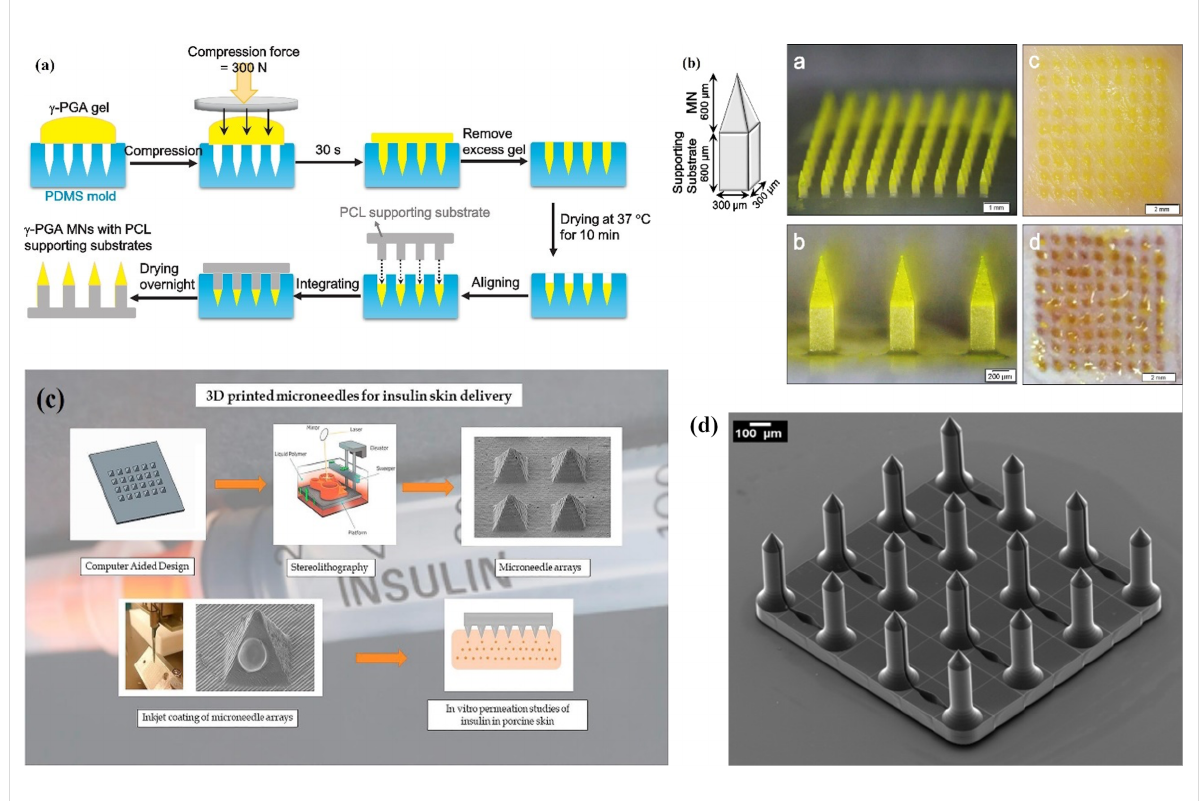
Figure 4: (a) A schematic representation of the manufacturing procedure for producing γ -PGA microneedles, (b) microneedles fabricated via the pro- cedure represented in (a) as used to penetrate pig and mouse cadaver skin [72]. (c) Stereolithography (STL) used to manufacture microneedle arrays followed by coatings of insulin and sugar solution using an inkjet printer [83]. Figure 4c reprinted with permission from ref. [83]. (d) An array of 16 microneedles (2.17 mm × 2.17 mm) with side channels connected to reservoirs, fabricated by two-photon polymerization; the microneedles have 700 μ m of total height, 150 μ m of flange height, and 150 μ m of tip height [5]. Figure 4a,b were reprinted from [72], Acta Biomaterialia, vol. 114, by Chen, M.-C.; Chen, C.-S.; Wu, Y.-W.; Yang, Y.-Y., “Poly- γ -Glutamate microneedles as transdermal immunomodulators for ameliorating